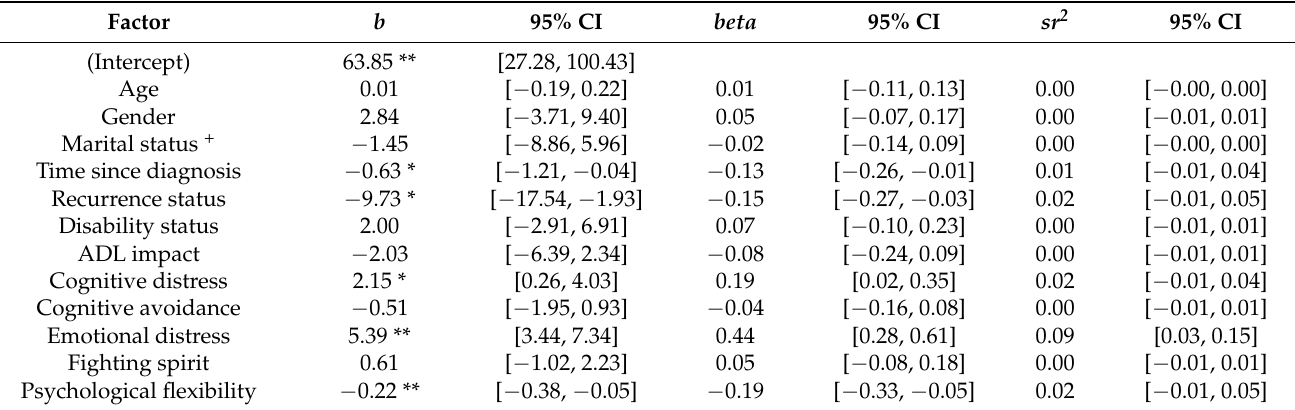
Table 3. Regression results for